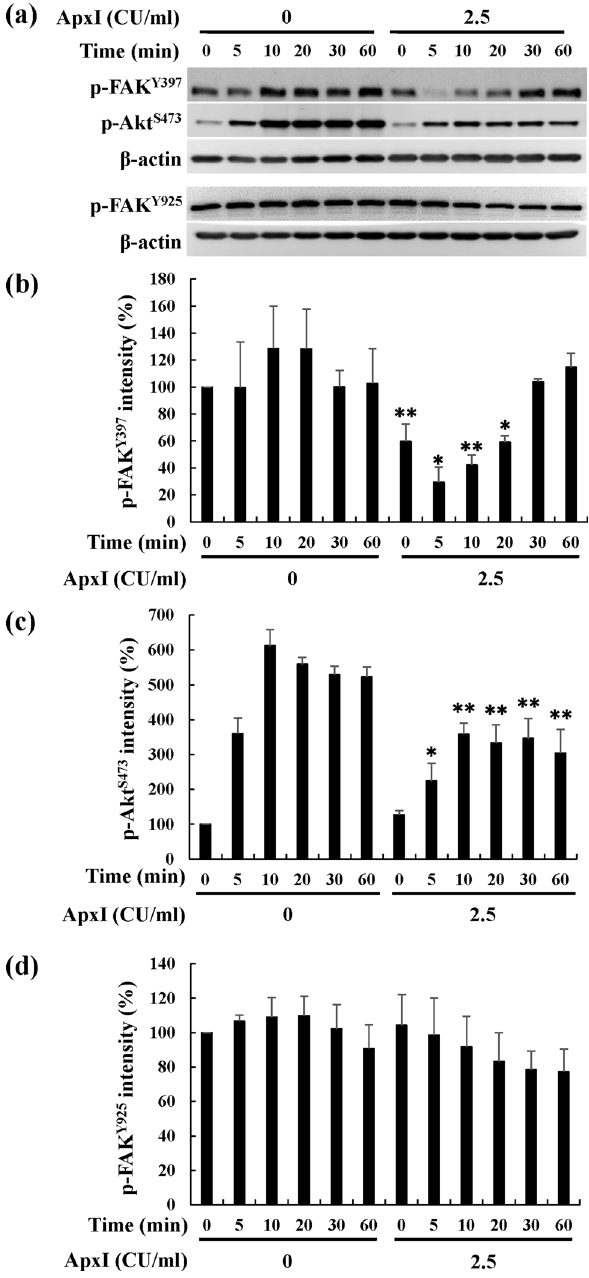
Figure 3. ApxI decreases FAK and Akt activity in porcine AMs. Porcine AMs were treated with 0 or 2.5 CU/ml ApxI for 0–60 min. Cell lysates were collected and subjected to ( a ) Western blot analyses for phospho-FAK Tyr397 (p-FAK Tyr397 ), phospho-FAK Tyr925 (p-FAK Y925 ), phospho-Akt Ser473 (p-Akt S473 ), and β-actin. The grouping of blots was cropped from different portions of two gels and exposed separately. Uncropped blot images for Fig. 3( a ) are presented in Supplementary Figure S2. The average intensities of ( b ) p-FAK Tyr397 , ( c ) p-Akt Ser473 , and ( d ) p-FAK Tyr925 were from three independent experiments and normalized to the intensity of β-actin. Asterisks indicate significant differences compared to the non-ApxI treatment group at the identical time point. * p < 0.05; ** p <